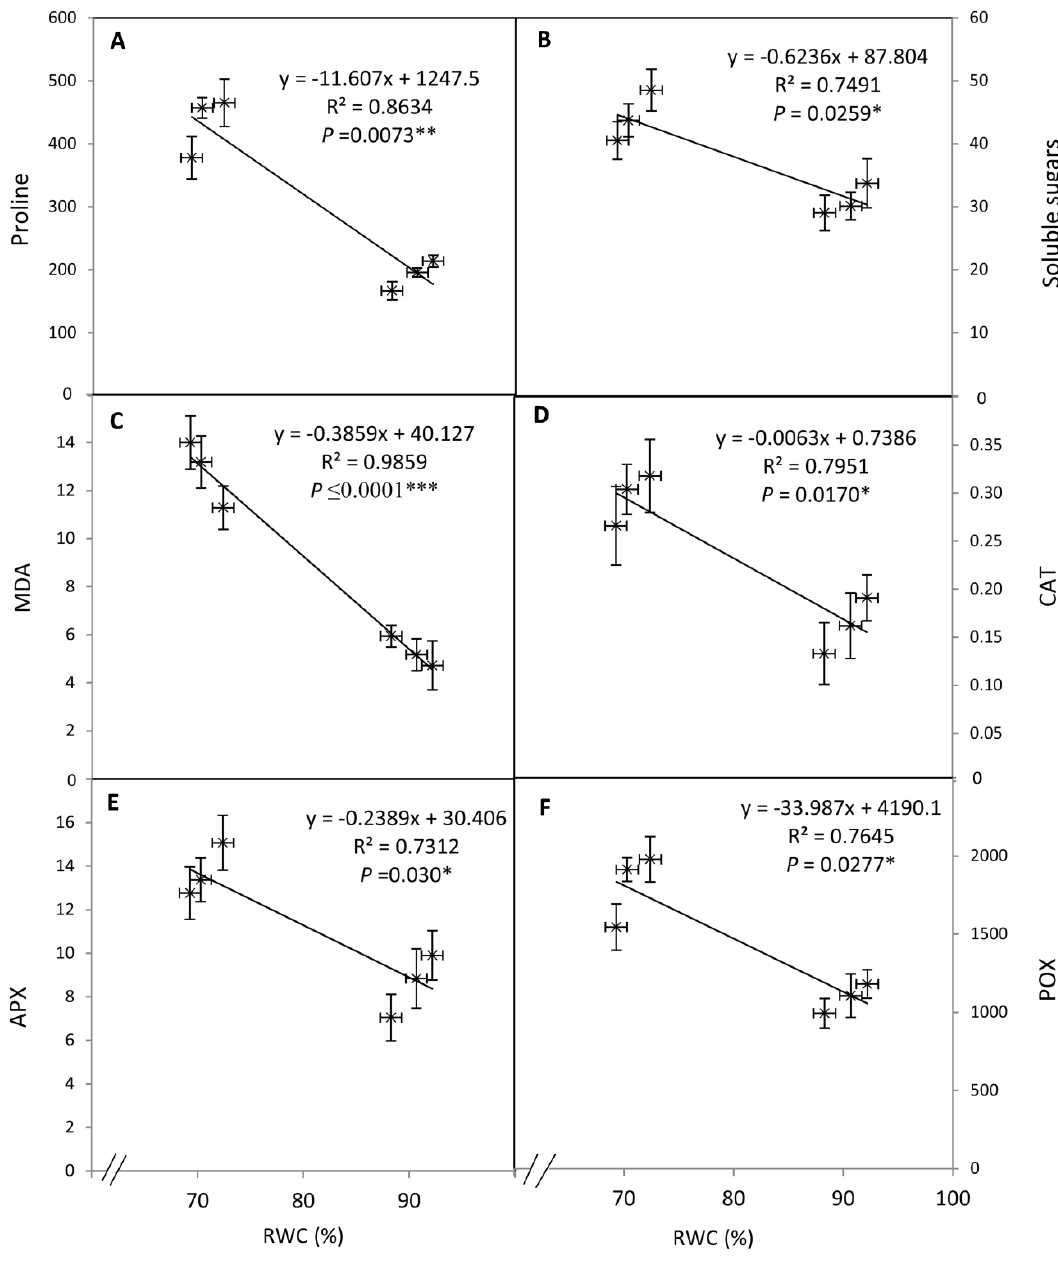
Figure 5. Relationships between osmolytes (proline and total soluble sugars), lipid peroxidation, antioxidant enzymes (CAT, APX, and POX), and RWC in the leaves of tomato plants as affected by SNP as foliar applications at 0, 50, and 100 µM under well-watered and water deficit irrigation regimes. NS: nonsignificant. * p ≤ 0.05; ** p ≤ 0.01; *** p ≤ 0.001.